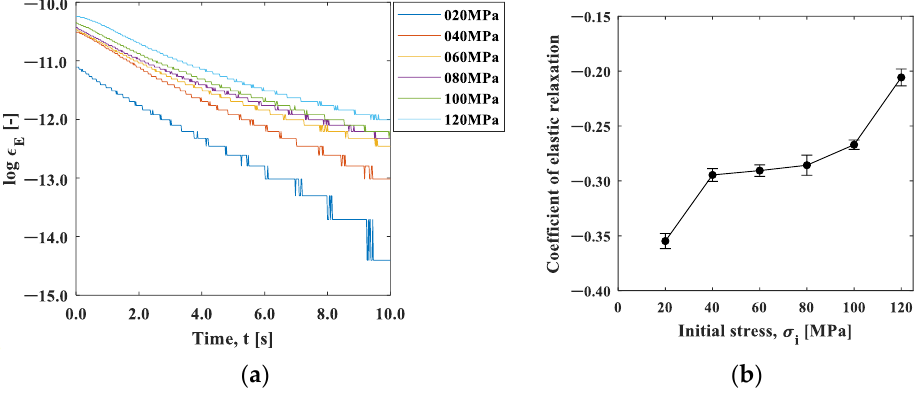
Figure 14. ( a ) Log (strain) – time curve; and ( b ) 𝐶𝐸𝑅 – initial stress curve.